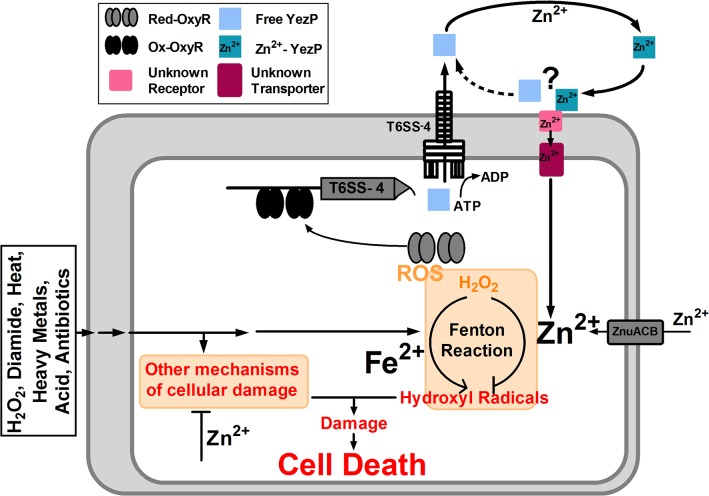
Model of T6SS-4-facilitated Zn2+ transportation and oxidative resistance in Yptb.OxyR activated by oxidative signals binds to the operator in the promoter of T6SS-4 to activate the expression of the system and its substrate YezP, leading to the production and assembly of the system, which translocates YezP into the extracellular milieu. YezP form a complex with Zn2+ to deliver the ions into the cell via a yet unknown mechanism. Intracellular Zn2+ mitigates the hydroxyl radicals or potentially other cell damaging processes to make the cells resistant to diverse environmental challenges.